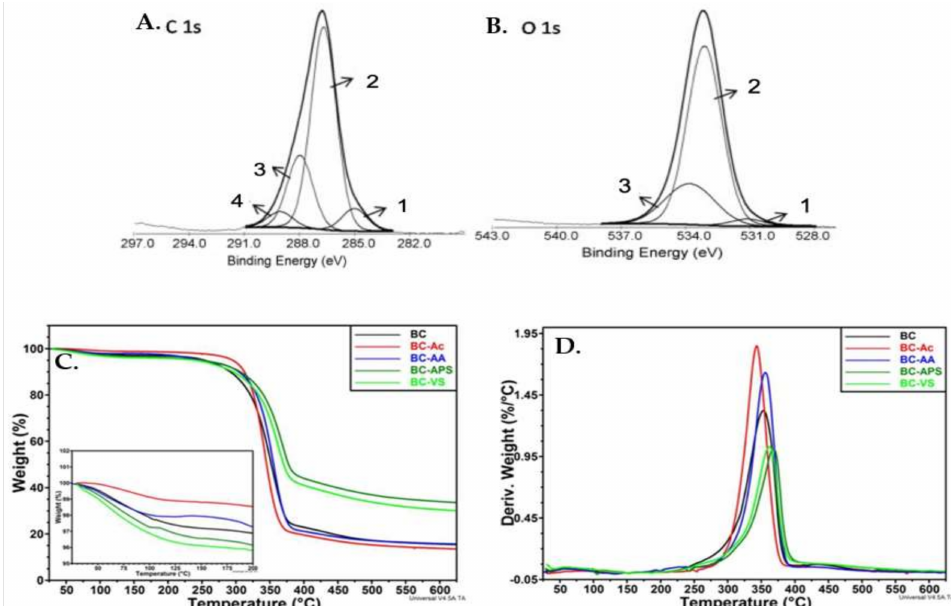
Figure 3. ( A , B ) High Resolution XPS spectra of C1s and O1s of pure BC. ( C , D ) TGA and DSC analysis from 3-aminopropyl triethoxysilane treated BC membrane (BC-APS), vinyl-triethoxy silane treated BC membrane (BC-VS), acrylated BC membrane (BC-AA), acetylated BC membrane (BC-AC). Inset ( C , D ): initial degradation step. Reproduced with permission from [41] (Copyright © 2022, Elsevier), [37] (Open